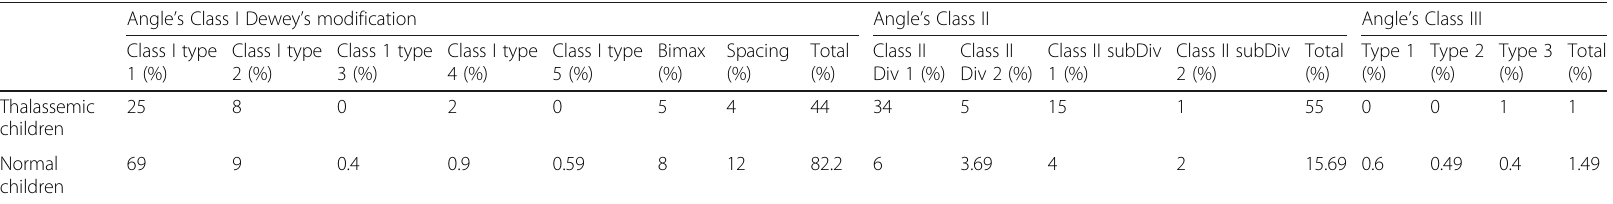
Table 1 Comparison of prevalence of Class I, Class II, and Class III malocclusion in thalassemic and normal